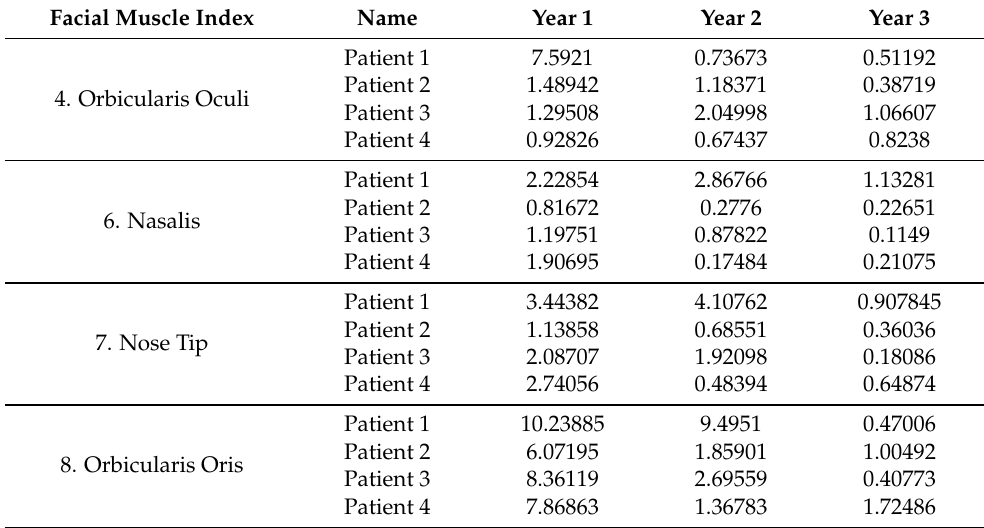
Table 6. Distance symmetry results for each facial muscle of patients by year in smile expression. Facial Muscle